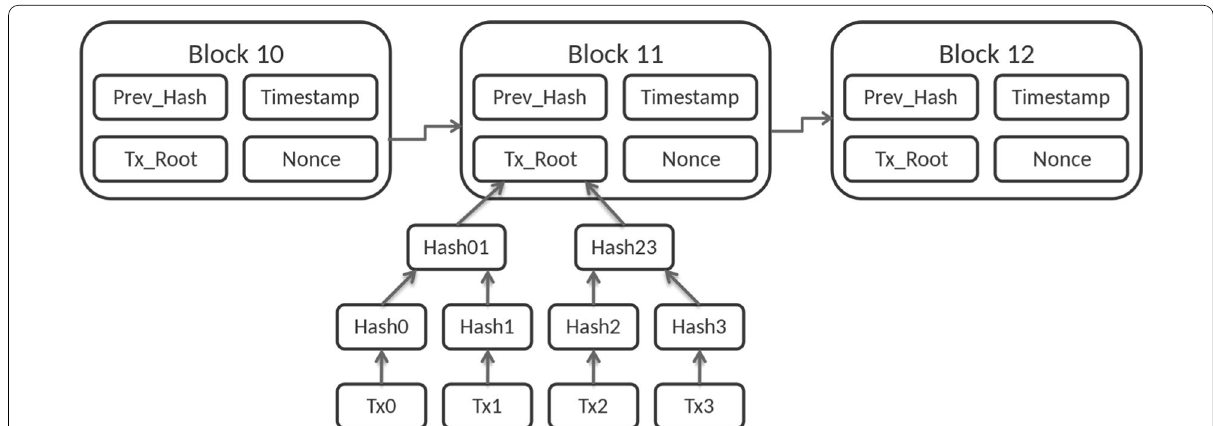
Fig. 1 Transactions in a blockchain. Blocks, Nodes and Hash: Blockchain structure of Bitcoin: The data is stored in a continously growing list (chain) of records (blocks). Figure by: Matthäus Wander—Own work, CC BY-SA 3.0, https:// commo ns. wikim edia. org/w/ index. php? curid